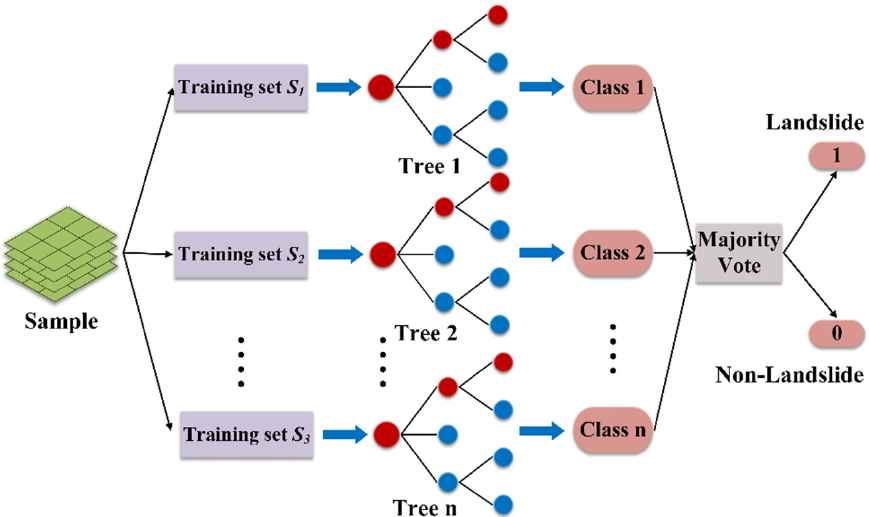
Figure 6. Flow chart of the random forest model used in this study.